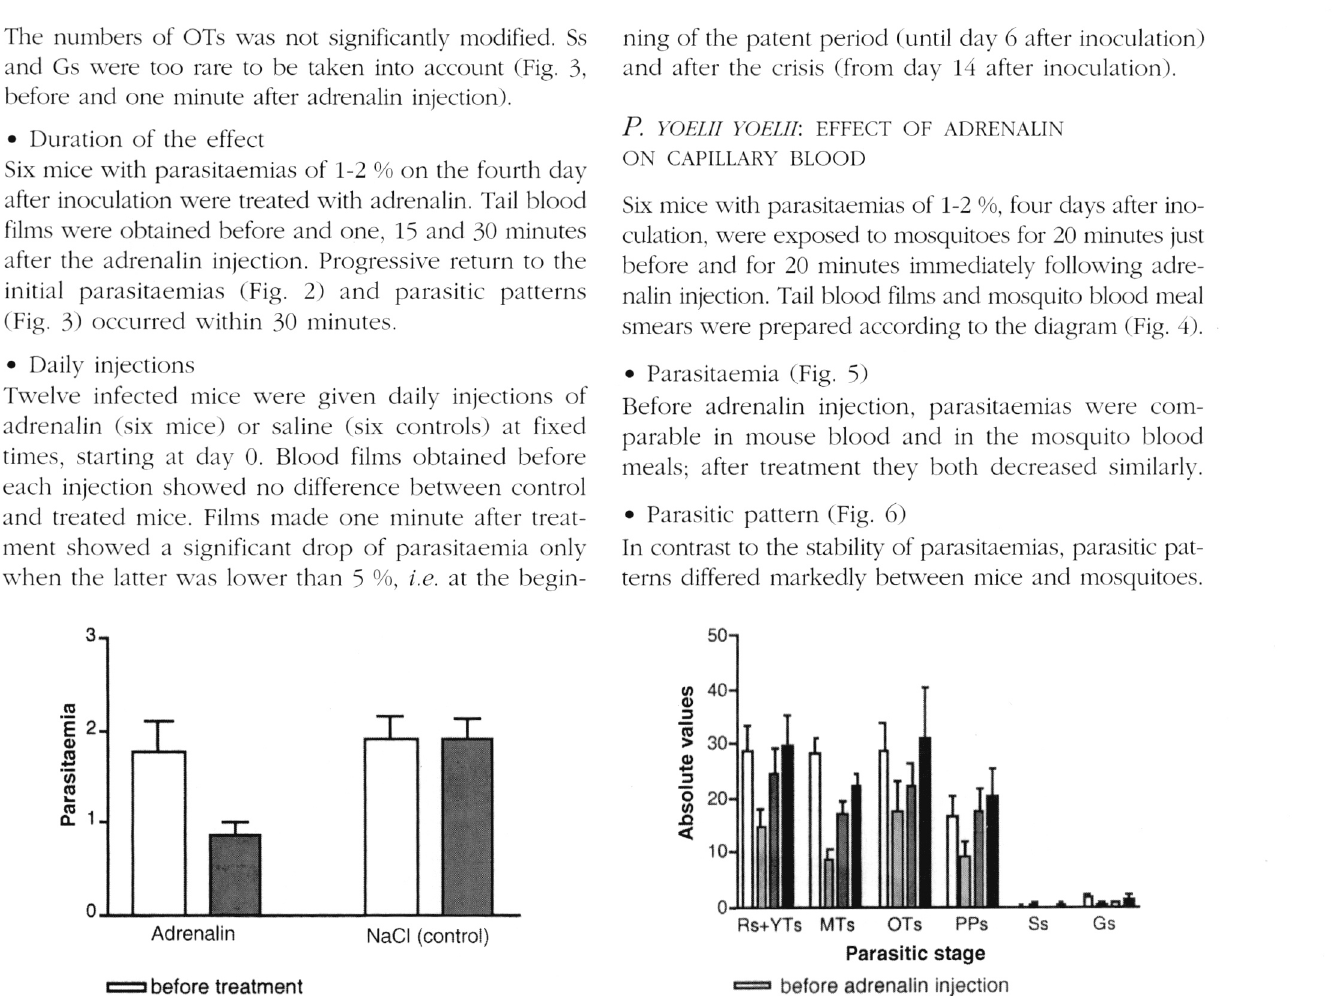
Fig. 3. - P. yoelii yoelii: effect of adrenalin on the parasitic pattern during 30 minutes following injection. Box-plots represent absolute values of parasitic stages and error bars indicate the SEM. Rs: rings; YTs: young trophozoites; MTs: midterm trophozoites; OTs: gametocytes.